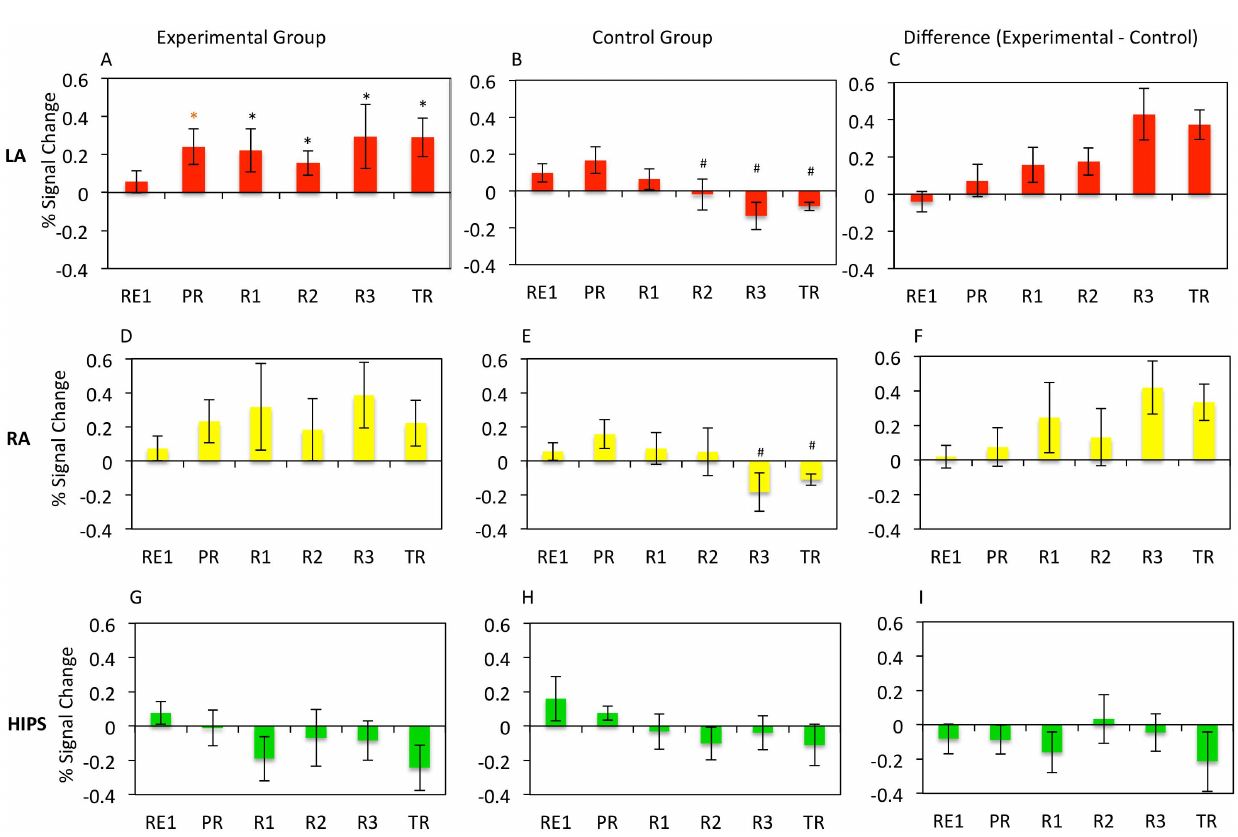
Figure 2. Percent BOLD Signal Change for each ROI, run, and group. Mean percent BOLD signal change for the Happy – Rest condition for each experimental run for the left amygdala (LA; panels A, B, C), right amygdala (RA; panels D, E, F), and horizontal segment of the intraparietal sulcus (HIPS; panels G, H, I) for the LA rtfMRI-nf group (panels A, D, G), HIPS rtfMRI-nf group (panels B, E, H), and for the difference between the LA and HIPS rtfMRI-nf groups (C, F, I). Error bars indicate + / 2 one standard error of the mean. * indicates a significant difference from 0 at p , 0.05. * indicates a significant difference from 0 at p , 0.10. # indicates a significant difference from the experimental group at p , 0.05.